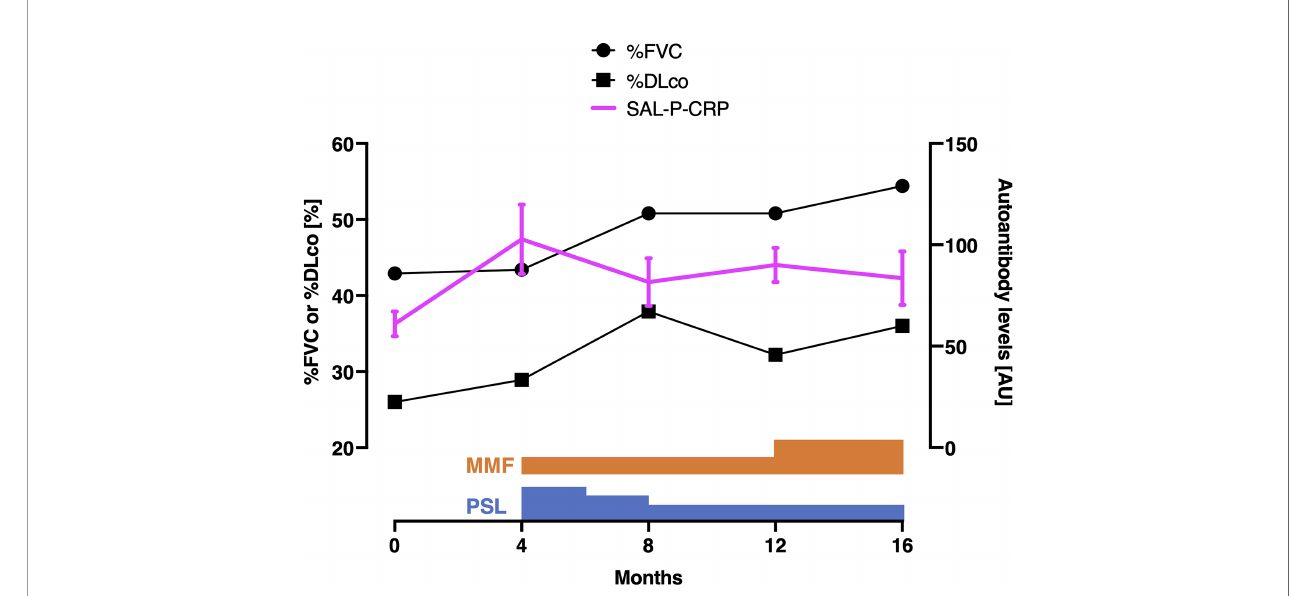
FIGURE 4 | Serial measurements of pulmonary function and autoantibody level in a patient with interstitial lung disease associated with systemic sclerosis. Scales for pulmonary function and autoantibody level are shown at the left and right, respectively. The values of sum of autoantibody levels that positively correlated with serum CRP with statistical signi fi cance (SAL-P-CRP) are described as the mean and the standard error of the mean of technical triplicates. %FVC: percentage of predicted forced lung vital capacity, %DLco: percentage of predicted lung diffusing capacity for carbon monoxide, PSL, prednisolone; MMF, mycophenolate mofetil; AU, arbitrary